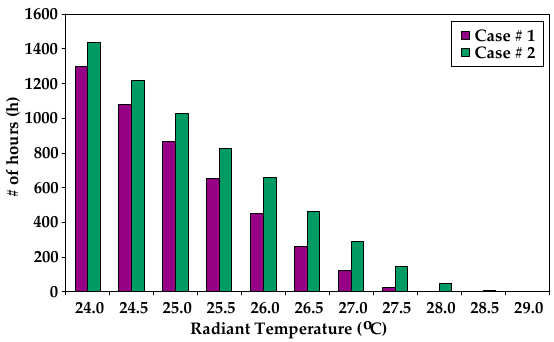
Figure 5. Radiant temperature distribution within the corridor area at Level 13.